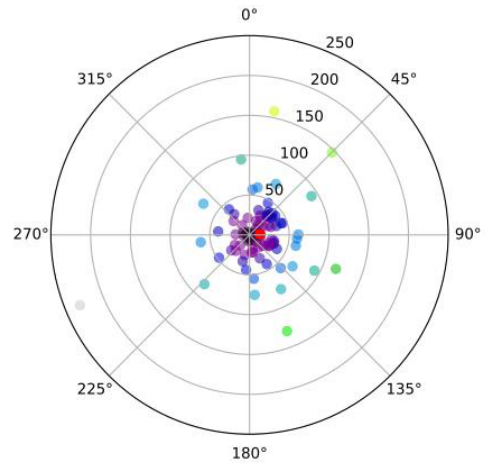
Figure 9. Polar scatter plot of the centroid offset. The centroids of the manually delineated harvesting site polygons are normalised to the axis zeros, and the differences to the centroids of the FCLE representations are plotted. The red point shows the average offset. Colours indicate distance classes.